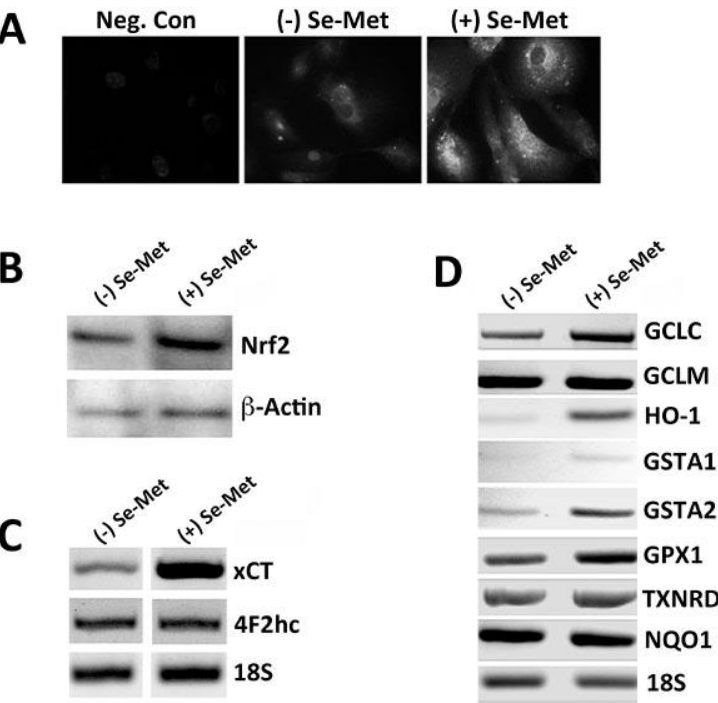
Figure 1. Selenomethionine (Se-Met)-induced upregulation of Nrf2 in ARPE-19 cells: ( A ) immunocytochemical analysis of Nrf2 protein in ARPE-19 cells cultured in the presence (+Se-Met) or absence ( − Se-Met) of selenomethionine (1 mM, 16 h), where cells in which PBS was substituted for the primary antibody served as the negative control (Neg. Con); ( B ) western blot analysis of Nrf2 in control and Se-Met-treated ARPE-19 cells; ( C ) RT-PCR analysis of mRNA transcripts specific for xCT (SLC7A11) and 4F2hc in control ( − Se-Met) and Se-Met-treated ARPE-19 cells; and ( D ) RT-PCR analysis of Nrf2 target genes: glutamate-cysteine ligase catalytic subunit (GCLC), glutamate-cysteine ligase regulatory subunit (GCLM), heme oxygenase-1 (HO-1), glutathione S-transferase A1 (GSTA1), glutathione S-transferase A2 (GSTA2), thioredoxin reductase (TXNRD), glutathione peroxidase (GPX), and NAD(P)H oxidase: quinone 1 (NQO1), in ARPE-19 cells cultured in the presence (+Se-Met) or absence (−Se-Met) of selenomethionine (1 mM, 16 h).